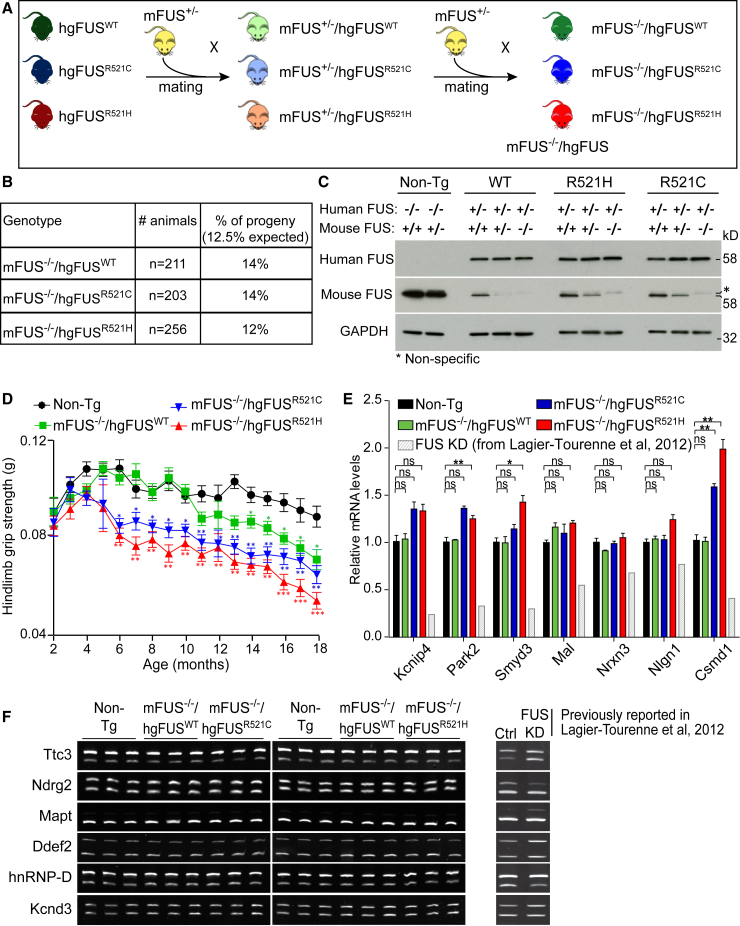
Progressive Motor Deficits Associated with ALS-Linked FUS Mutants Without Reduction in FUS Function(A) Schematic of the two-round mating of hgFUS mice with FUS mice heterozygous for mouse FUS (mFus+/−) to produce animals in which all FUS is human wild-type or mutant (mFus−/−/hgFUS).(B) Number and Mendelian ratio of animals obtained from the two-step mating.(C) Human and mouse FUS protein accumulation in 2-month old mouse spinal cords using FUS antibodies specific for human and mouse proteins. GAPDH was used as a loading control. Asterisk illustrates a non-specific band detected with the mouse-specific FUS antibody.(D) Hindlimb grip strength measured bi-weekly from 2 to 18 months of age. Data are represented as mean ± SEM (n ≥ 15 per group). ∗p < 0.05, ∗∗p < 0.01 and ∗∗∗p < 0.001 using one-way ANOVA.(E) Expression levels of candidate genes (known to be reduced in the CNS of mice depleted of FUS [light gray], previously reported in Lagier-Tourenne et al., 2012; figure 3I) in 18-month-old Non-Tg, mFus−/−/hgFUSWT, mFus−/−/hgFUSR521C, and mFus−/−/hgFUSR521H mouse spinal cords. Data are represented as mean ± SEM (n ≥ 3 per group). ∗p < 0.05, ∗∗p < 0.01, two-sided unpaired Student’s t test.(F) Splicing profile of candidate genes (known to be altered in the CNS of mice depleted of FUS, previously reported in Lagier-Tourenne et al., 2012; figure 4C) in 18-month-old Non-Tg, mFus−/−/hgFUSWT, mFus−/−/hgFUSR521C, and mFus−/−/hgFUSR521H mouse spinal cords. See also Figure S4.